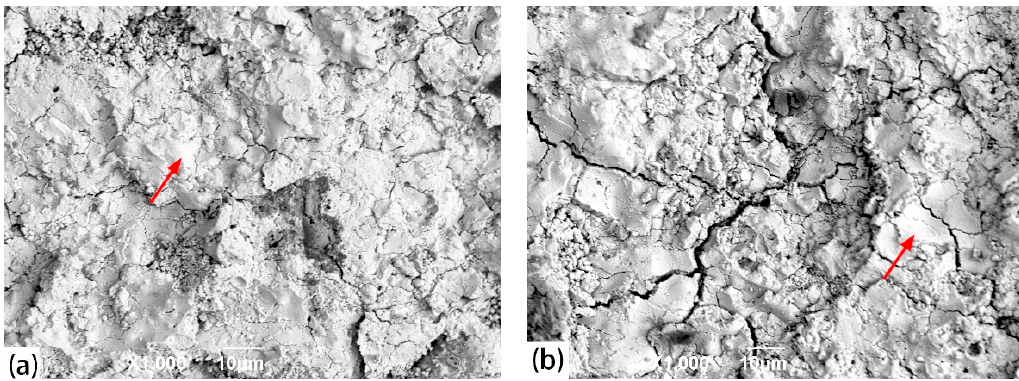
Figure 7. Surface morphologies of TBCs after sample failure: ( a ) type A and ( b ) type B.